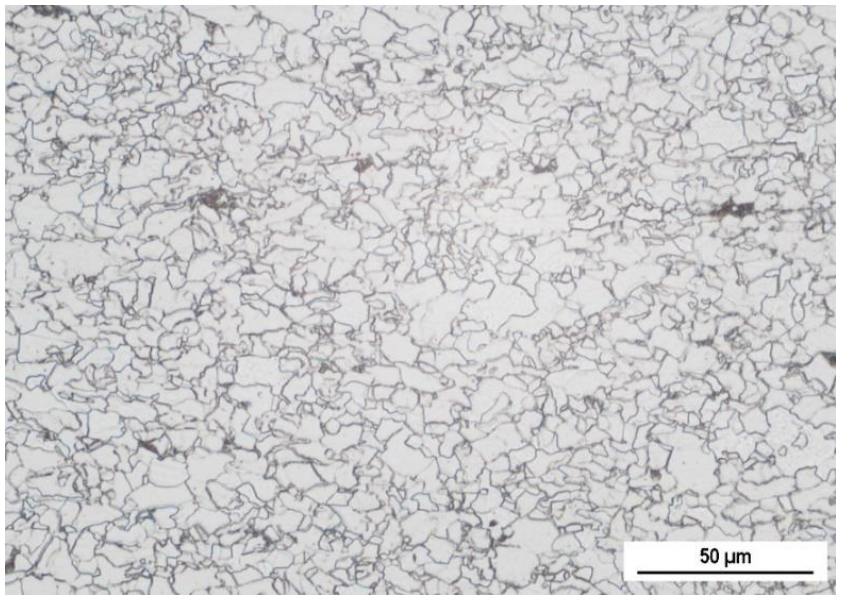
Figure 1. Fine ferrite matrix of S460MC, 3% Nital.